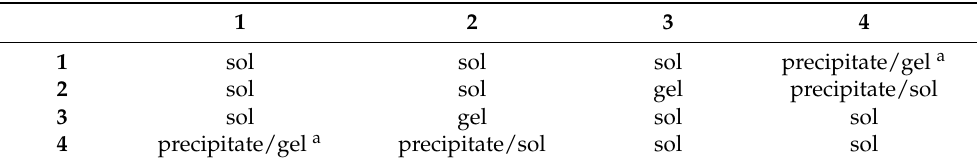
Table 1. Results of phase transition after mixing 1 , 2 , 3, or 4 in 1:1 ratio.